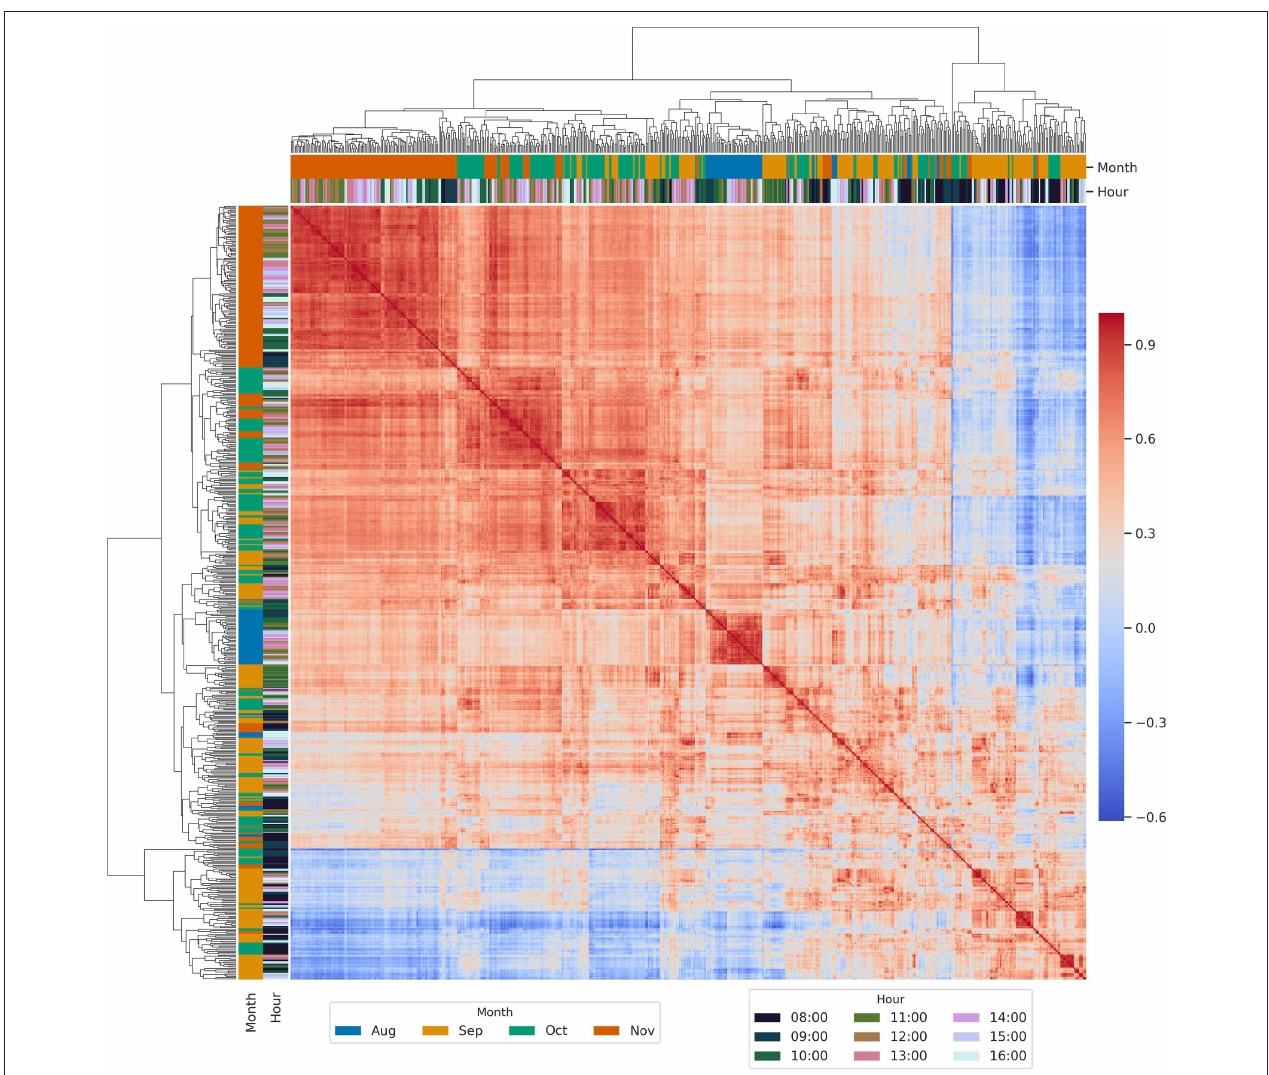
FIGURE 5 | Hierarchically-clustered heatmap of all possible pairwise phenotypic correlations between best linear unbiased predictors of genotype effects (BLUPs) for ArduCrop canopy temperature in 2017. Frequency distributions of the phenotypic correlations are shown in Figure S11